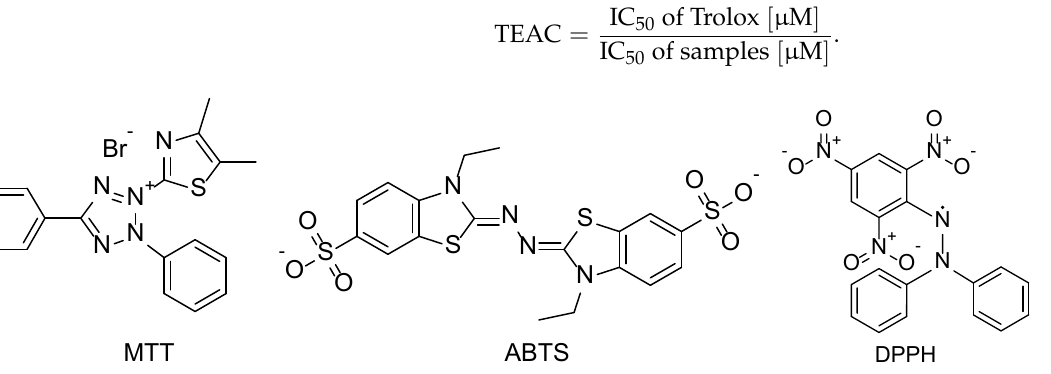
Figure 5. Structures of radicals used in antioxidant assays.